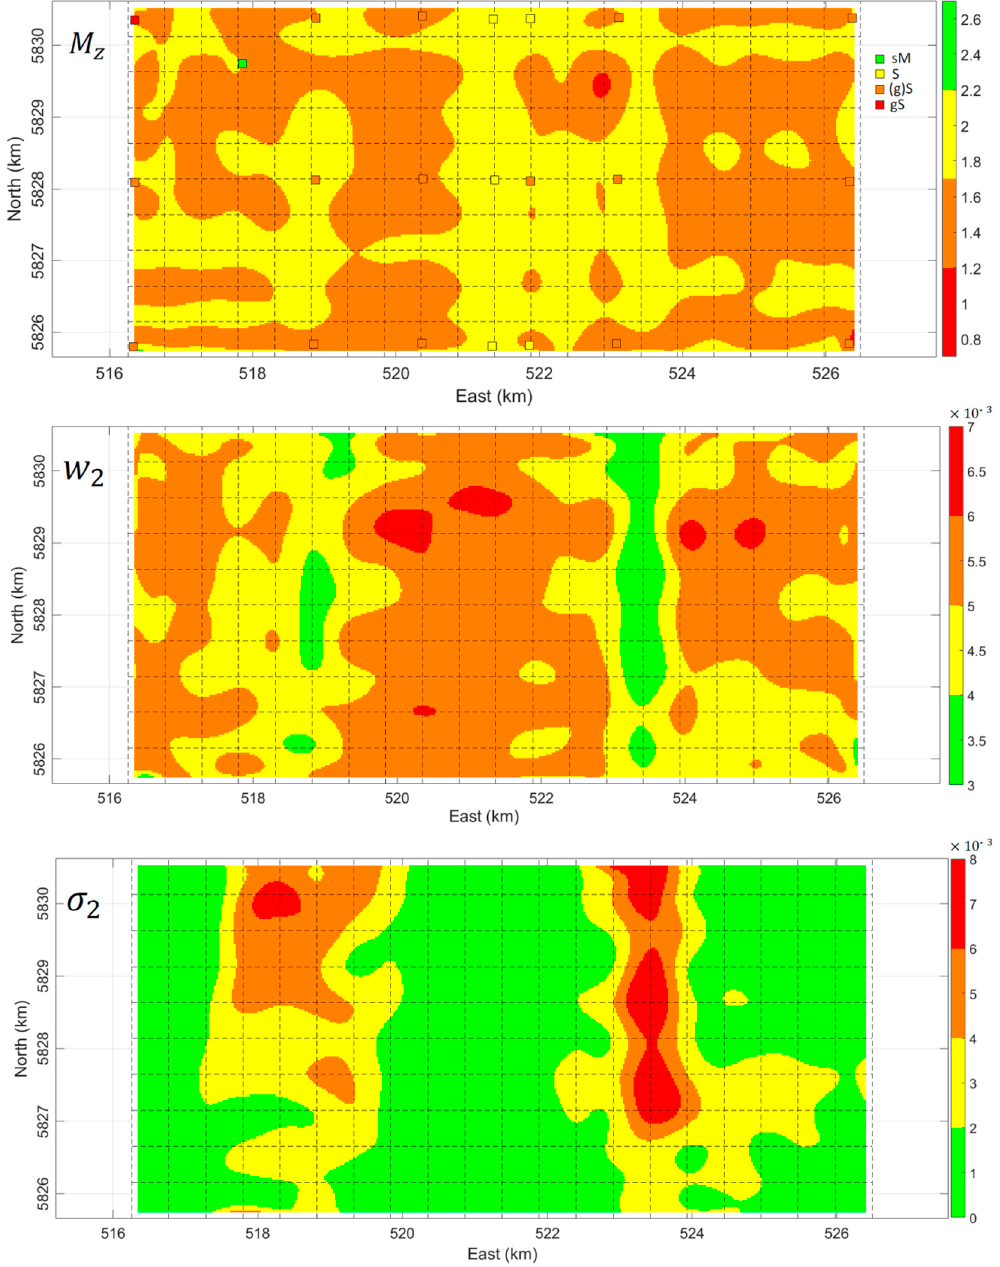
Figure 6. Smoothed maps of inverted mean grain size M z ( top ), spectral strength w 2 ( middle ), and volume scattering parameters σ 2 ( bottom ). Indicated in top frame also mean grain sizes of grab samples based on Folk classification scheme. Dashed line indicates square patches connected to each other using LS-BICSA method (Amiri-Simkooei et al. [49]).